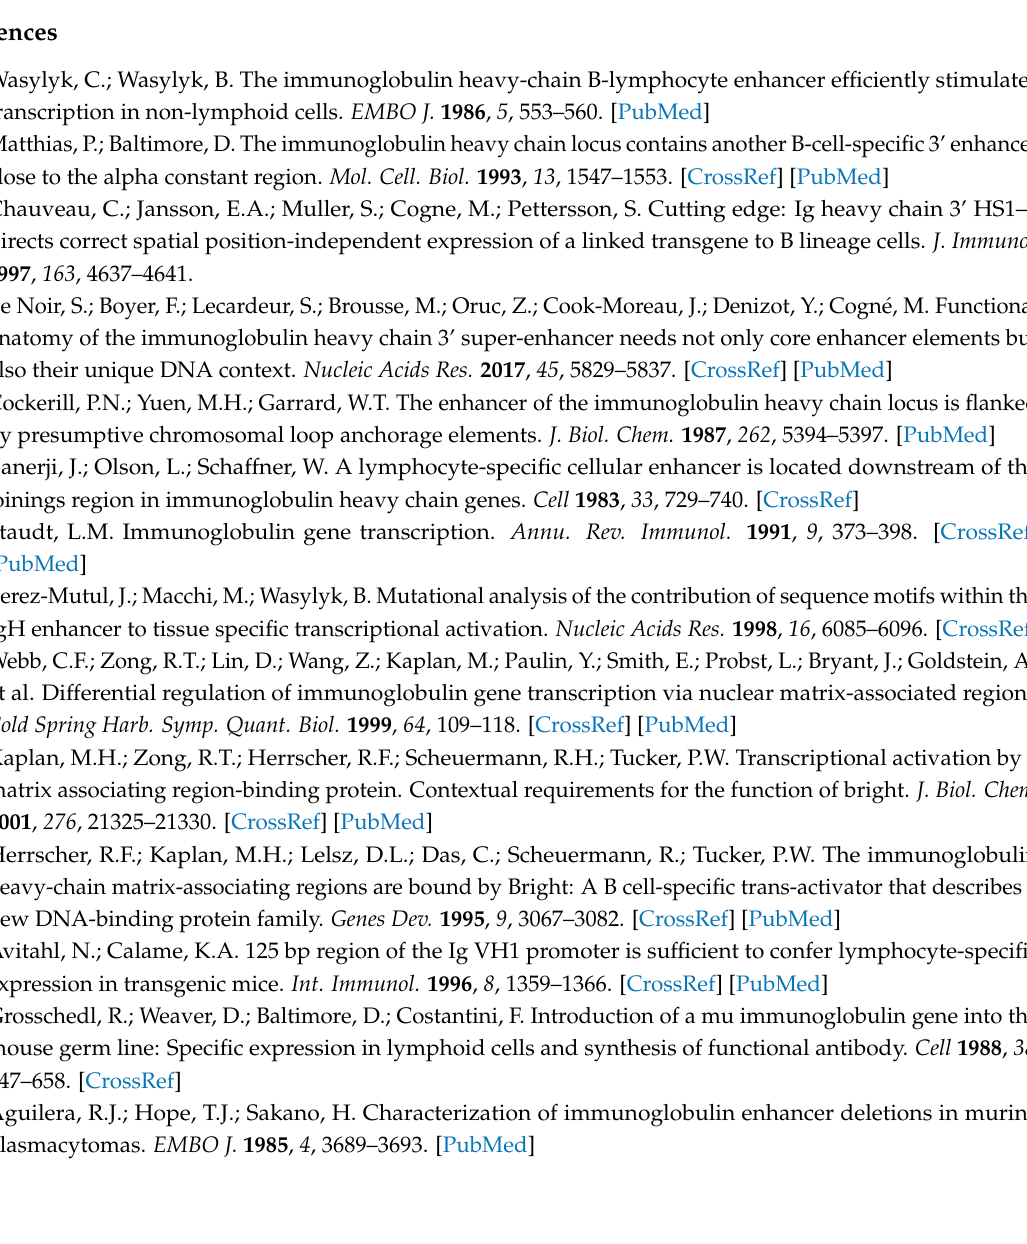
Supplementary Materials: The following are available online. Figure S1: Intronic (E µ ) and 3 (cid:48) enhancers within the IgH locus. (A) E µ is composed of a core enhancer and two flanking MAR regions. MAR regions contain four A/T-rich P-site protein binding motifs (hatched boxes) and the core enhancer contains several motifs (open boxes). Transcription factors are shown under the motifs to which they bind; (B) IgH 3 (cid:48) enhancer is comprised of four DNase I hypersensitive sites (open boxes and arrows). HS3a and HS4 are inverted repeats that form palindrome structures; (C) Position of MARs within the rearranged IgH locus. Closed ovals indicate MARs; open